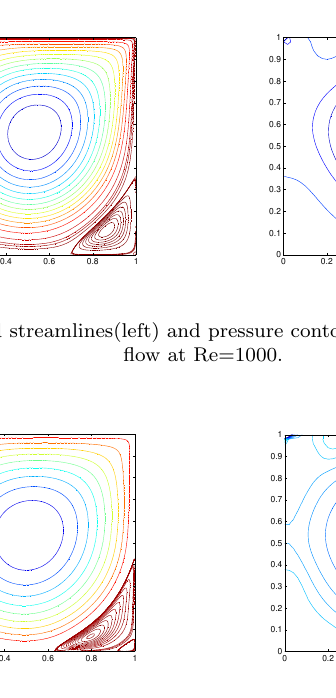
Figure 4. Computed streamlines(left) and pressure contours(right) for lid-driven cavity flow at Re=5000.